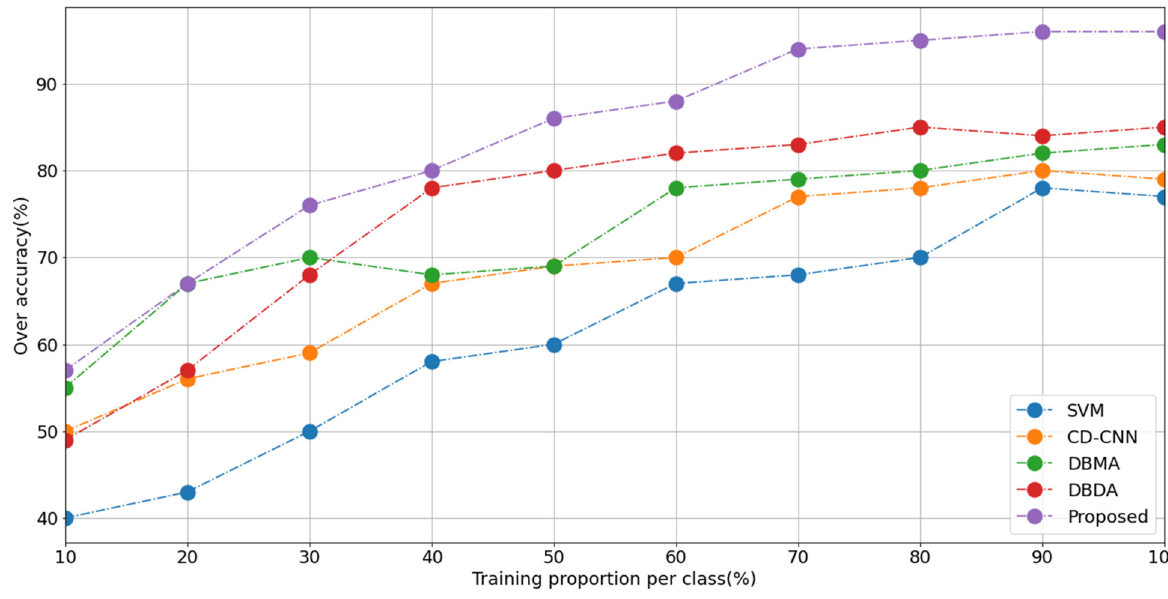
Figure 7. Accuracy with the proportion of training samples.